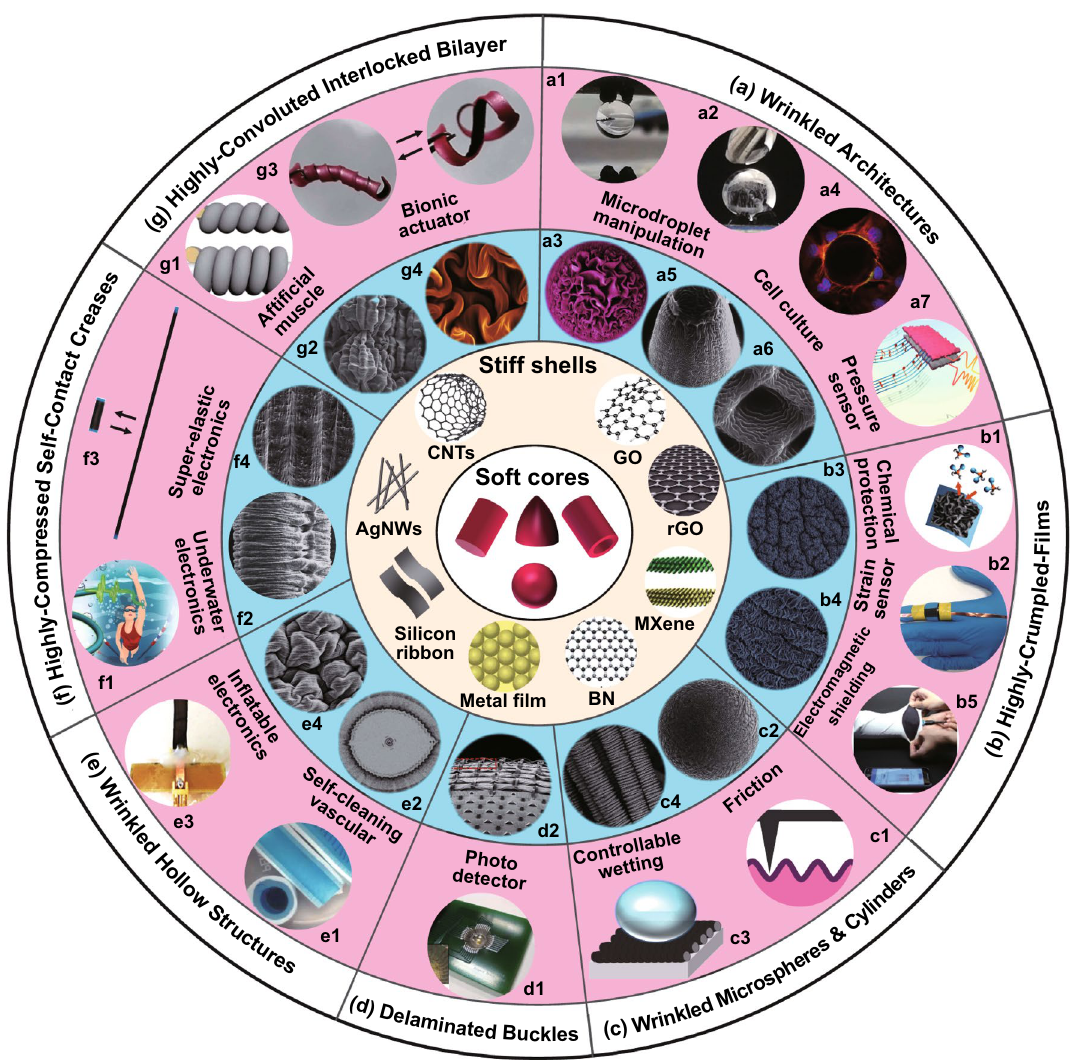
Fig. 18 Applications of diverse wrinkling structures on curved substrates. a Wrinkled architectures for controllable adhesion. a1‑a3 Flower- like papillae for microdroplet manipulation [54]. Copyright 2019 Wiley. a4‑a6 Patterned microarchitectures for cell attachment [185, 205]. a4 Adapted with permission from Ref. [185]. Copyright 2016 Springer Nature. a5 , a6 Adapted with permission from Ref. [205]. Copyright 2015